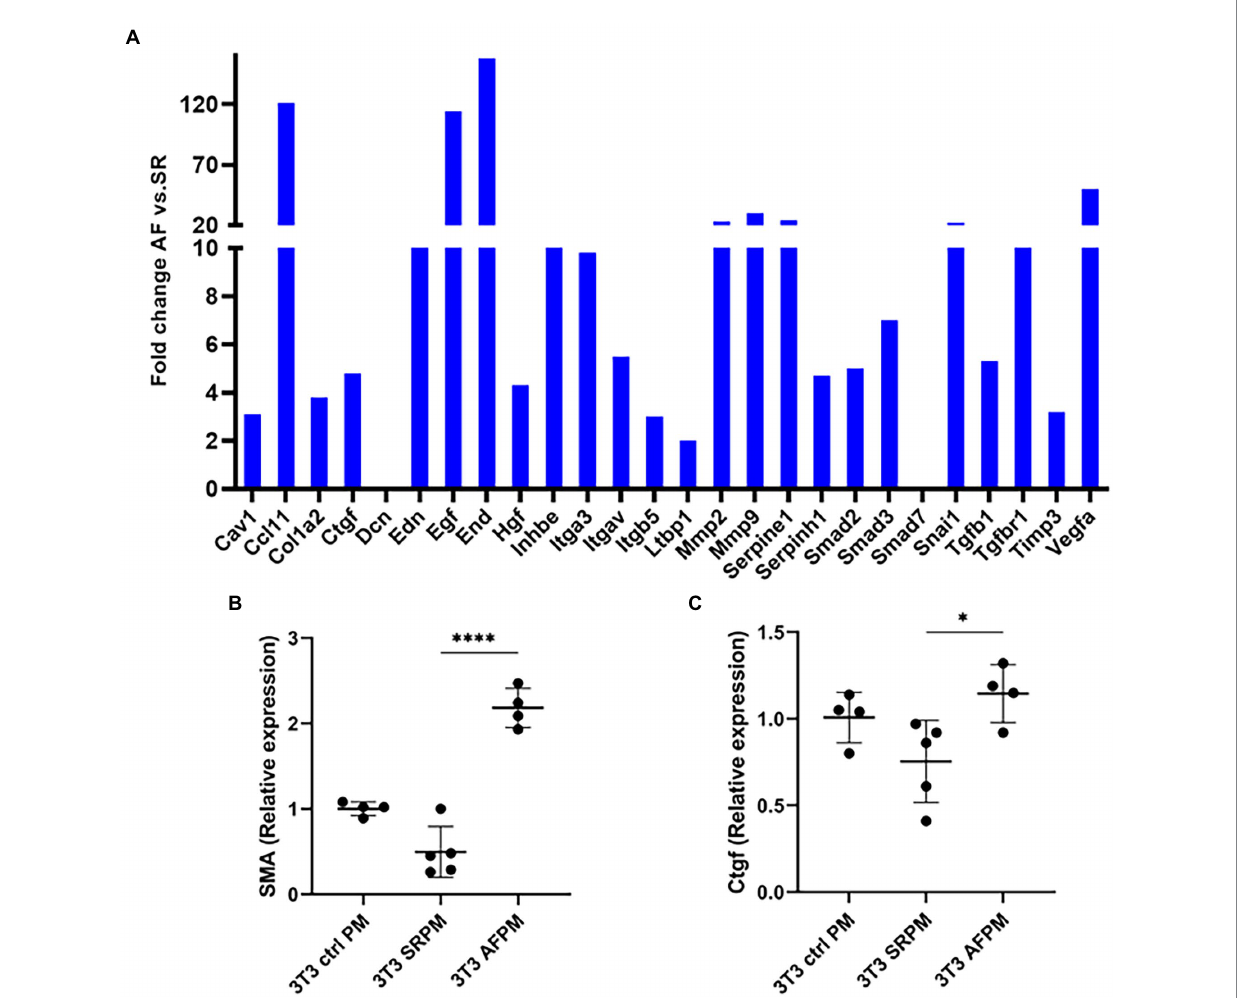
FIGURE 3 miR-21 released from cardiomyocytes induces pro-fibrotic pathways in NIH/3 T3 fibroblasts. (A) The medium of tachyarrhythmic paced cardiomyocytes was transferred to fibroblasts and incubation was done for 72 h, then the pathway analysis was performed. A fibrosis profiler array showed a strong induction of pro-fibrotic pathways and collagen expression in the NIH/3 T3 cells incubated with AF medium. Each sample type represents a pool of one 6 well plate. The induction is especially true for the fibrosis markers α -SMA (B) and Ctgf (C) . (B,C) Representative data out of 3 similar experiments. Data are expressed as mean ± SEM. **** p < 0.0001, * p < 0.05. Cav1: caveolin-1, Ccl11: c-c motif chemokine 11, Col1a2: collagen type I alpha 2, Ctgf: connective tissue growth factor, Dcn: decorin, Edn: endothelin, Egf: epidermal growth factor, End: endoglin, Hgf: hepatocyte growth factor, Inhbe: inhibin subunit beta E, Itga3: integrin subunit alpha3, Itgav: integrin alpha V, Itgb5: integrin beta 5, Ltbp1: latent transforming growth factor- β -binding protein-1, Mmp2: matrix metalloproteinase-2, Mmp9: matrix metalloproteinase-9, Serpine1: serpin family E member 1, Serpinh1: serpin family H member 1, Smad2: SMAD family member 2, Smad3: SMAD family member 3, Smad7: SMAD family member 7, Snai1: snail family transcriptional repressor 1, Tgfb1: transforming growth factor beta 1, Tgfbr1: transforming growth factor beta receptor 1, Timp3: tissue inhibitor of metalloproteinases-3, Vegfa: vascular endothelial growth factor a, α -SMA: alpha smooth muscle actin, Ctrl PM: control pacing medium, SRPM: sinus rhythm pacing medium, AFPM: atrial fibrillation pacing